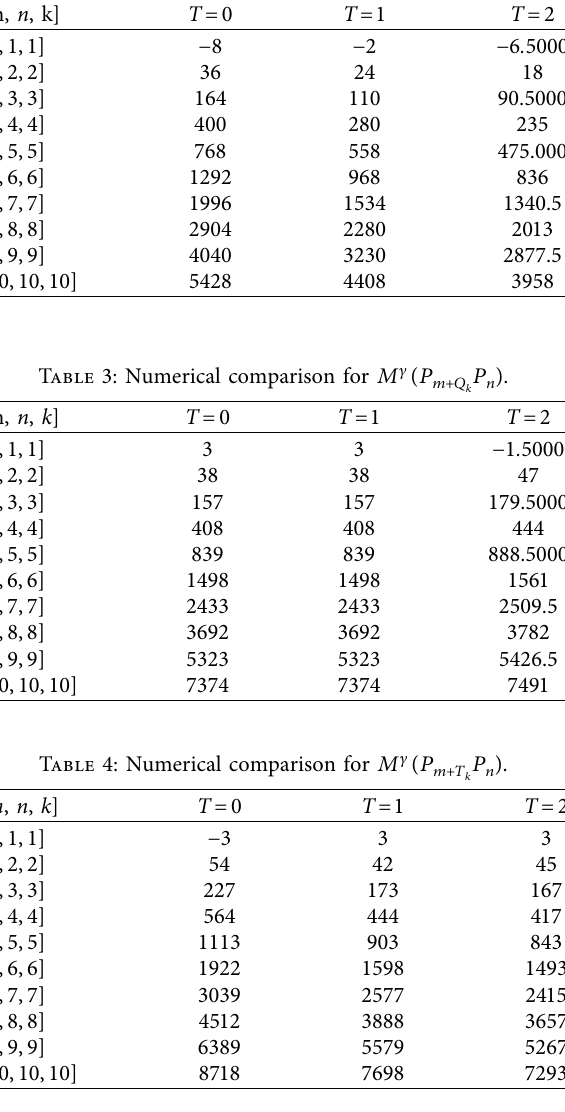
Table 2: Numerical comparison for M c ( P